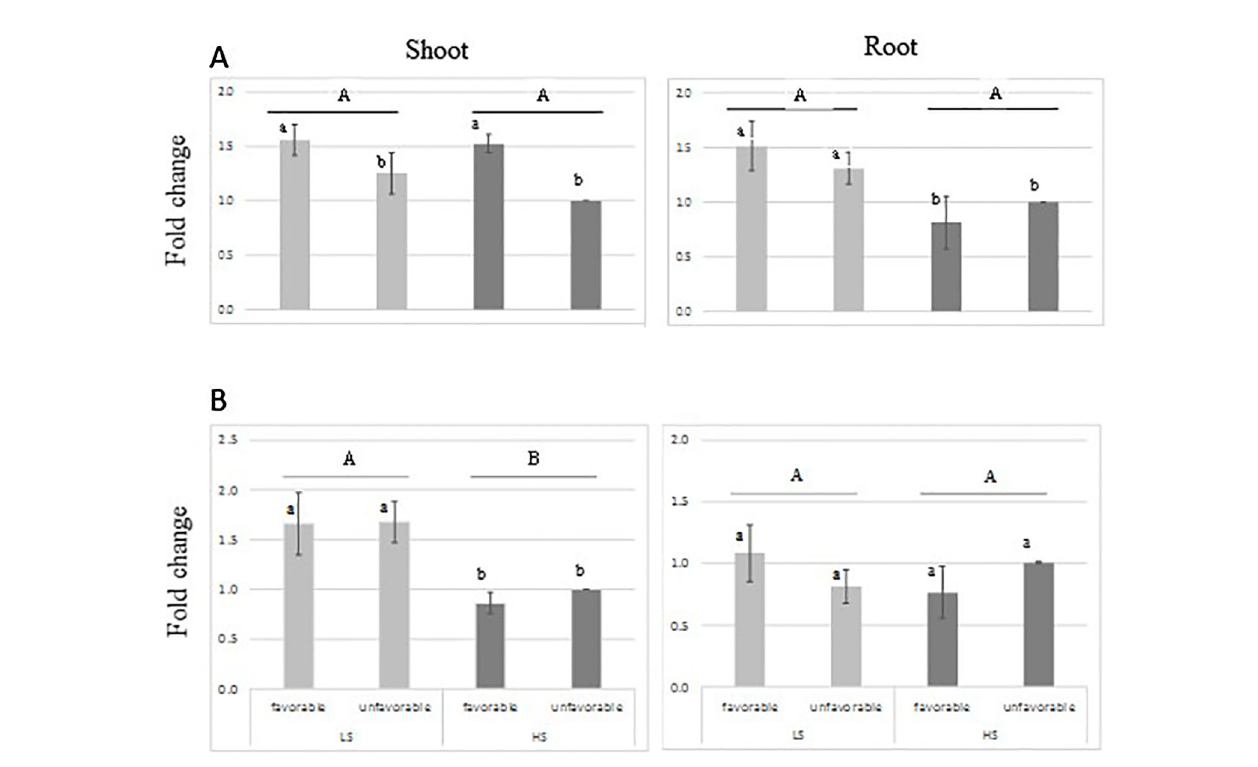
FIGURE 5 | Relative expression of sulfotransferase genes: Os11g0503900 (A) and Os11g0505300 (B) in root and leaves tissue from genotypes harboring favorable/unfavorable haplotypes for total dry matter. Plants were grown either under low-S or high-S condition. Data represent the mean (± standard error, SE) of three independent replications (n=4) and analyzed by two-way ANOVA. Different letters indicate signi fi cant difference within either factor: S treatment (capital letter) or haplotype group (small letter) according to Tukey's Honest Signi fi cant Difference test ( P < 0.05). ANOVA results are provided in Supplementary Table S4 - 3 in Data Sheet 1 . Favorable haplotype group: Santhi Sufaid 207, Kangro, Juma and DJ123. Unfavorable group: Surja Mukhi, Harbhoondi, Khadasiya3 and